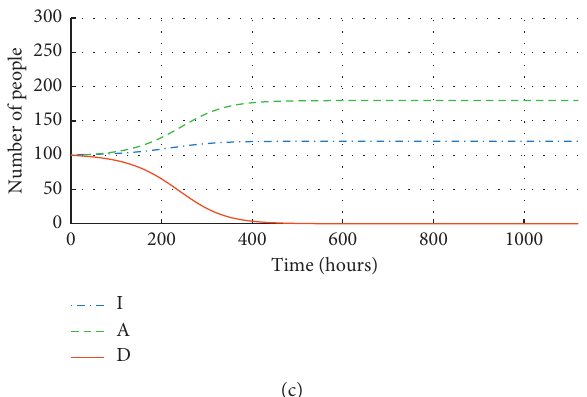
Figure 4: Examples of the steady state E I ( 0 ) � 100 , A ( 0 ) � 100, and D ( 0 ) � 100 and parameters’ values 1 simulated with initial conditions from Table 3. (a) Example 5. (b) Example 6. (c) Example 9.